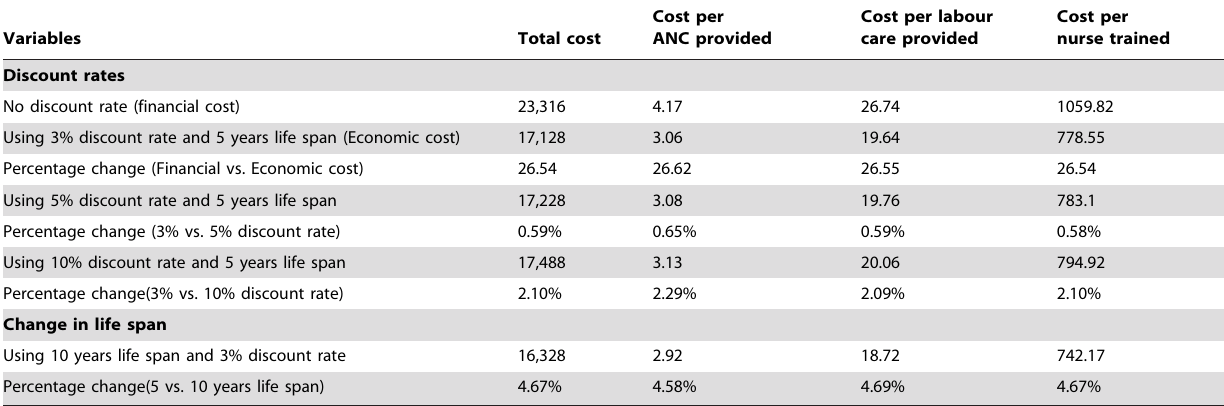
Table 6. Sensitivity